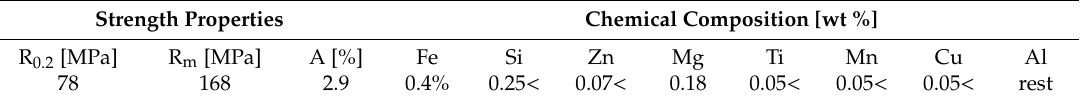
Table 3. Strength properties and chemical composition of the AA1050